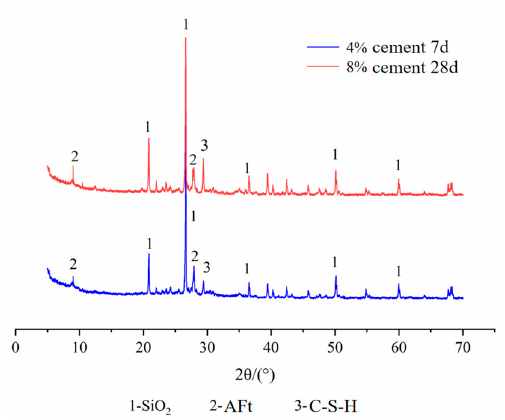
Figure 11. XRD diffraction pattern of silt.